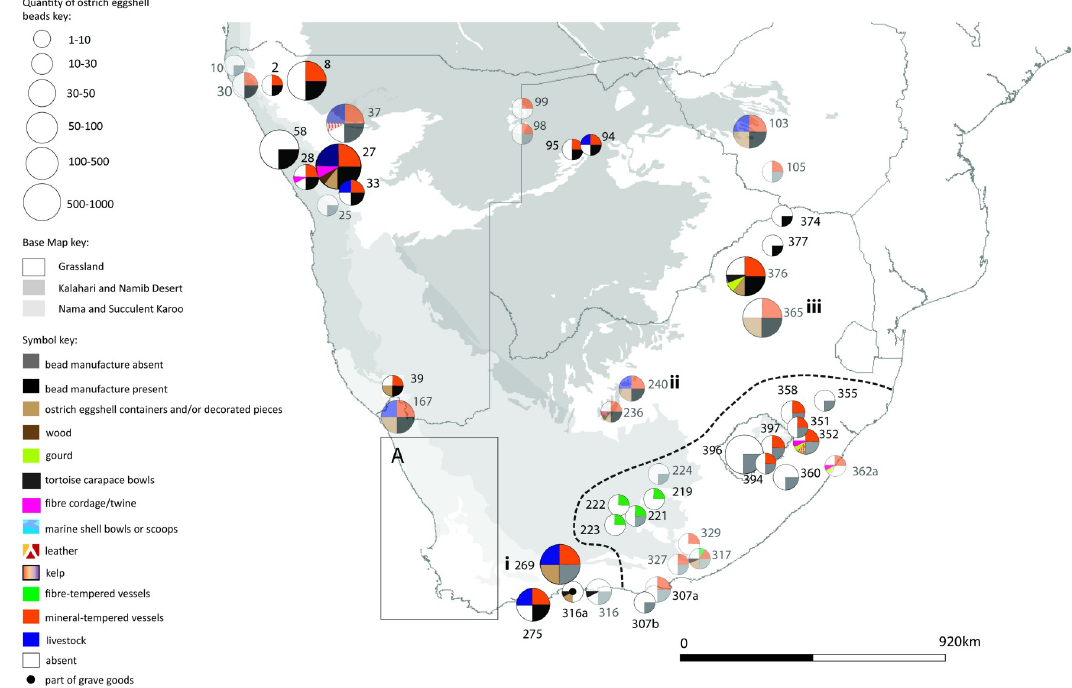
Fig 11. Map showing the southeastern part of South Africa and possible source areas for pottery and beads.